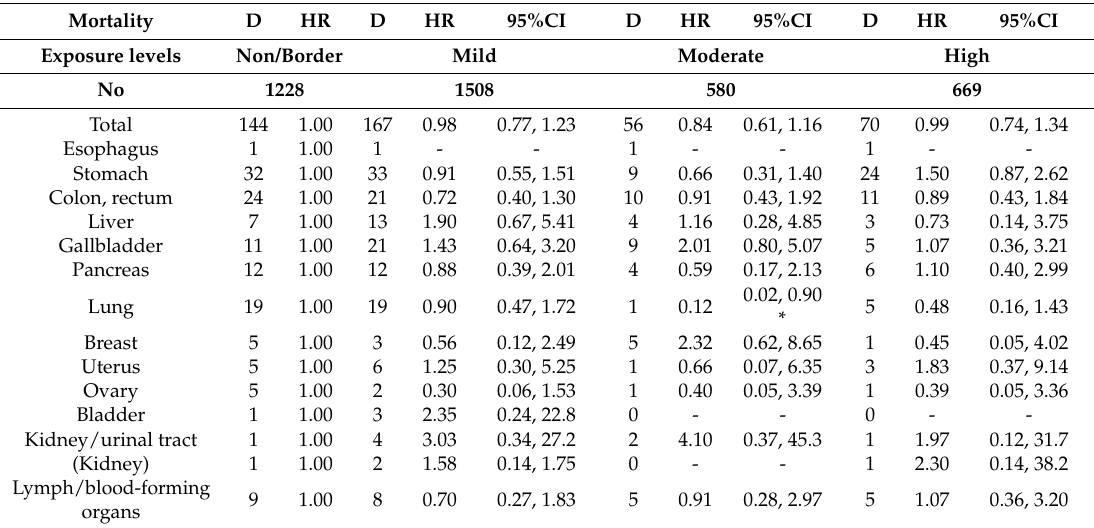
Table 6. Mortality risk ratios for cancer in three exposed female groups compared with women living in the areas with borderline exposure in the Cd-exposed Jinzu River basin.